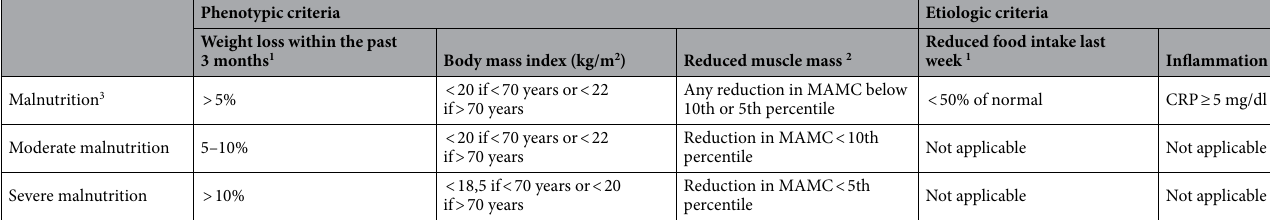
Table 1. Phenotypic and etiologic criteria applied in the nutritional assessment. Weight loss, BMI, MAMC, food intake and inflammation are suggested by GLIM for the diagnosis of malnutrition. GLIM, Global Leadership Initiative on Malnutrition; MAMC, mid-arm muscle circumference; CRP, c-reactive protein. 1 Self-reported food intake < 50% of normal during the last week and self-reported weight loss > 5% within past 3 months from a study questionnaire. 2 Age and sex specific cut-offs for MAMC were applied 22 . 3 At least 1 phenotypic criterion and 1 etiologic criterion was required for the diagnosis of